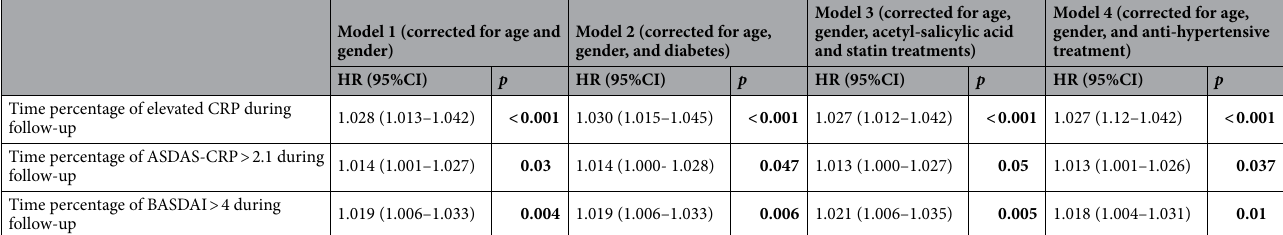
Table 4. Multivariable Cox Proportional Hazard Models considering as dependent variable the occurrence of the first CV event during follow-up. Each independent variable (time percentage of elevated CRP during follow-up; time percentage of ASDAS-CRP > 2.1 during follow-up; or time percentage of BASDAI > 4 during follow-up) was tested in four models: model 1, corrected for age and gender; model 2, corrected for age, gender, and diabetes; model 3, corrected for age, gender, acetyl-salicylic acid and statin treatments; model 4, corrected for age, gender, and anti-hypertensive treatment. HR hazard ratio; CI confidence interval; CRP C-reactive protein; ESR erythrocyte sedimentation rate; BASDAI Bath Ankylosing Spondylitis Disease Activity Index; ASDAS Ankylosing Spondylitis Disease Activity